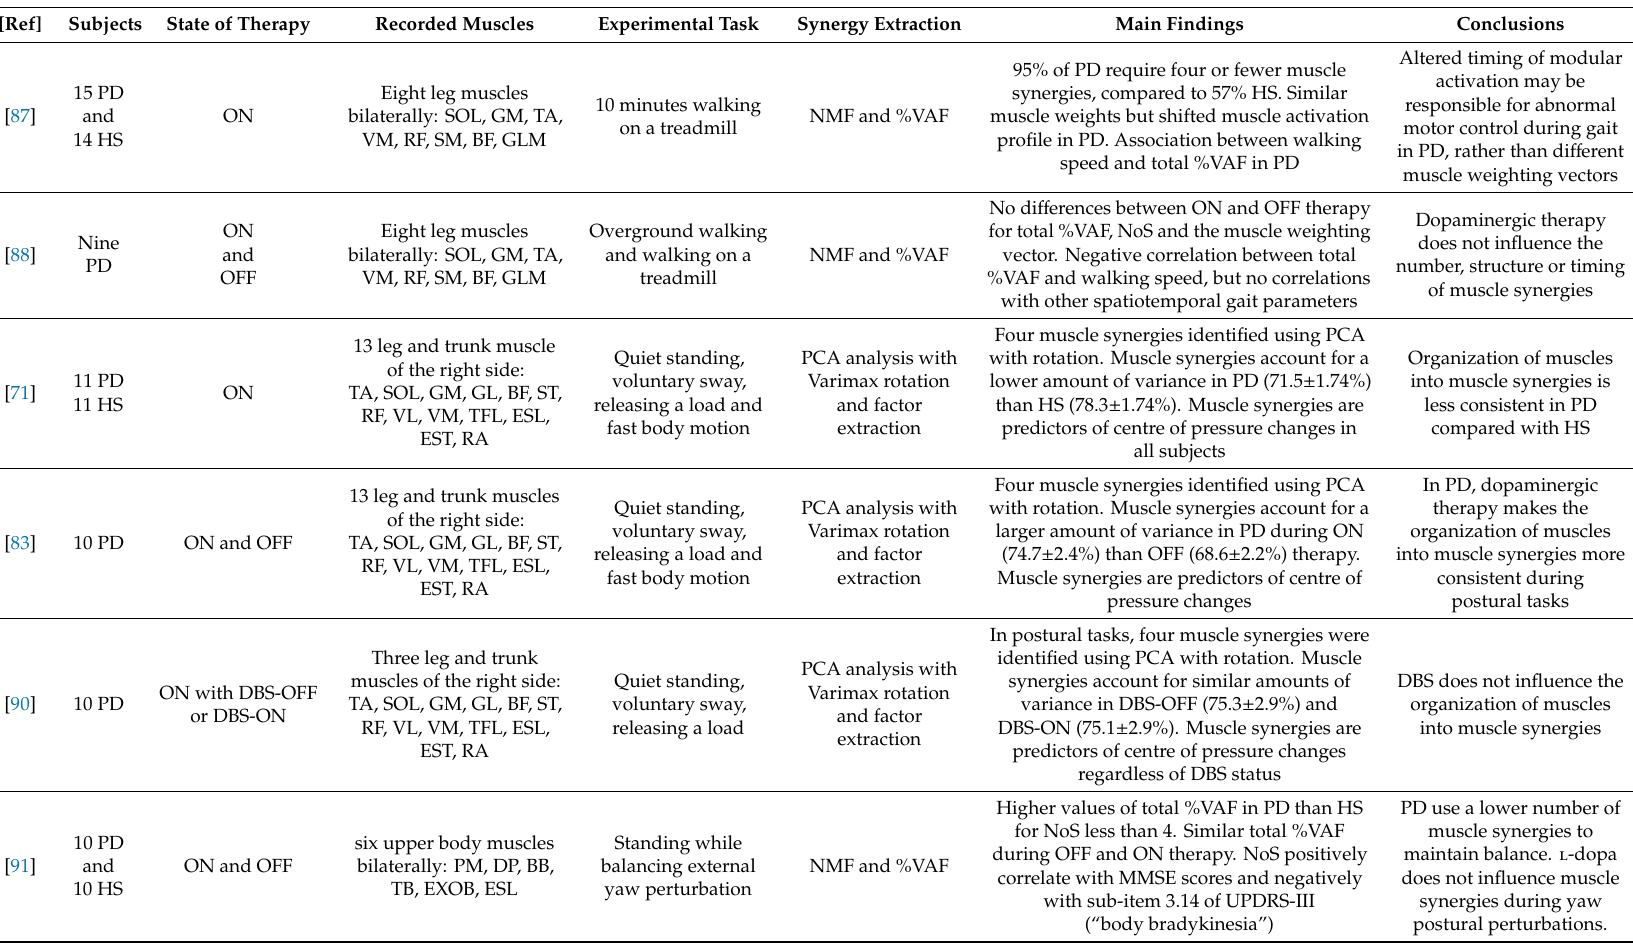
Table 2. Experimental studies investigating muscle synergies in Parkinson’s